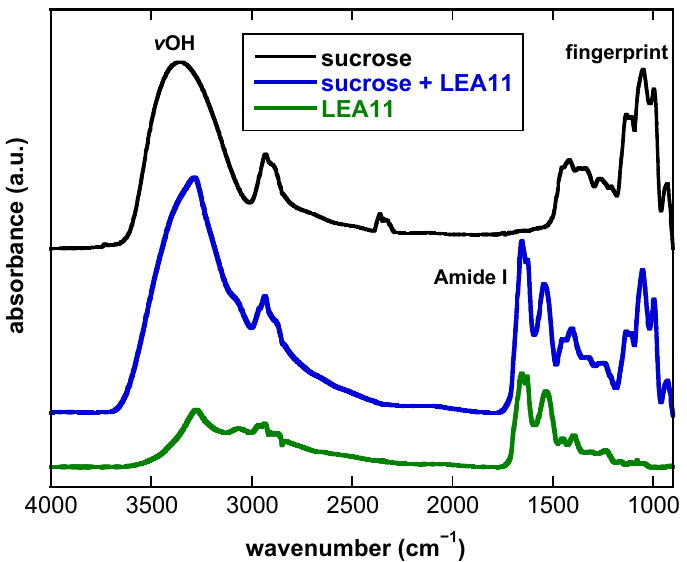
Figure 1. FTIR absorbance spectra of dry samples prepared from 10 mg/mL Suc, from 10 mg/mL Suc and 5 mg/mL LEA11, and from 2 mg/mL LEA11. Suc and LEA11 were dissolved in water, and samples were then dried on CaF 2 windows. Spectra were recorded at 30 °C. The OH-stretching vibration peak ( ν OH) of the sugar, the amide I peak of the protein and the fingerprint region of the sugar spectrum are indicated. a.u.—arbitrary units.